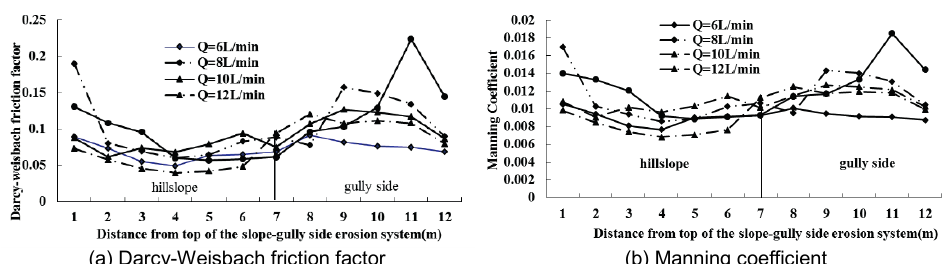
Fig. 4 Longitudinal variations of Darcy-Weisbach friction factor and Manning